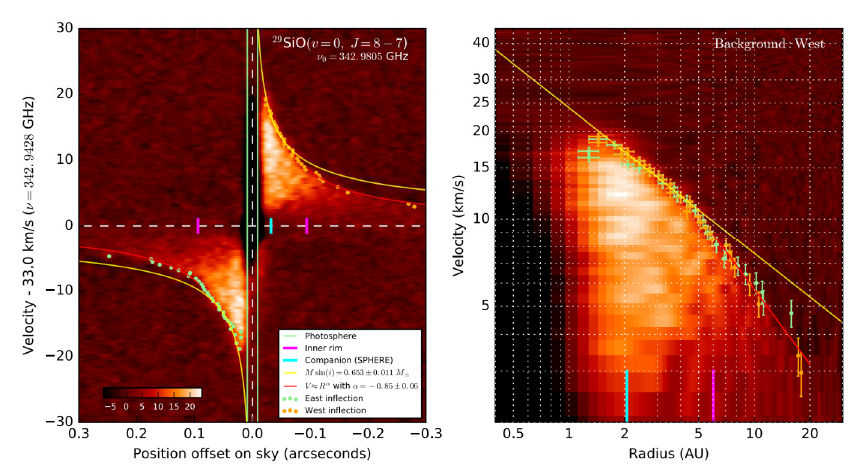
Figure 6 : L 2 Pup: Position-velocity diagrams plotted inside the slit shown in Figure 5. The yellow curve is a Keplerian fit to the inner cavity, and the red curve is a power law fit to the non-Keplerian radius